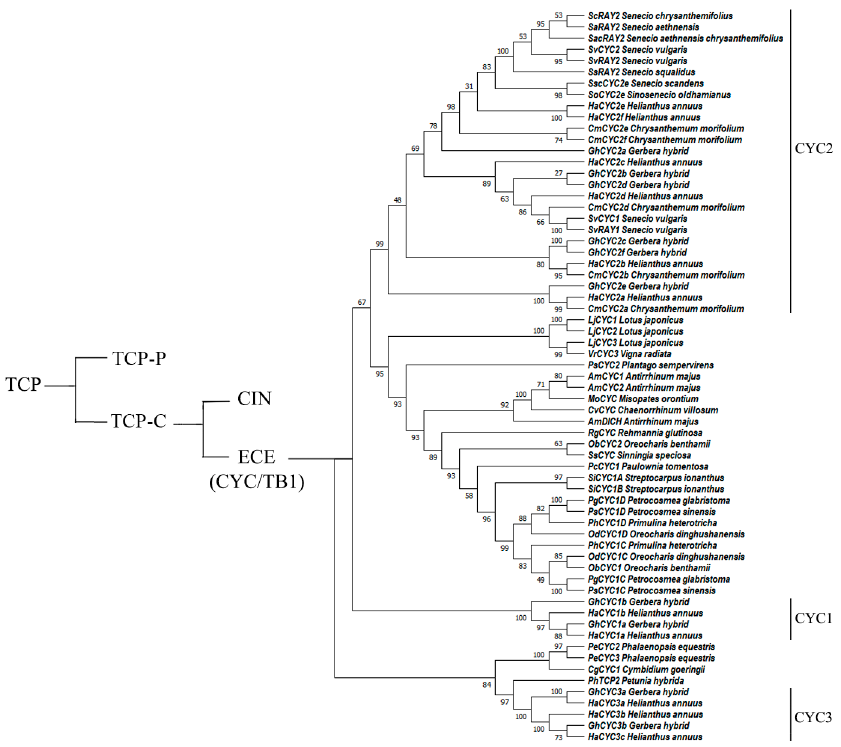
Figure 1. Phylogenetic tree of selected CYC -like genes in angiosperms. The number beside each node is the bootstrap support value.